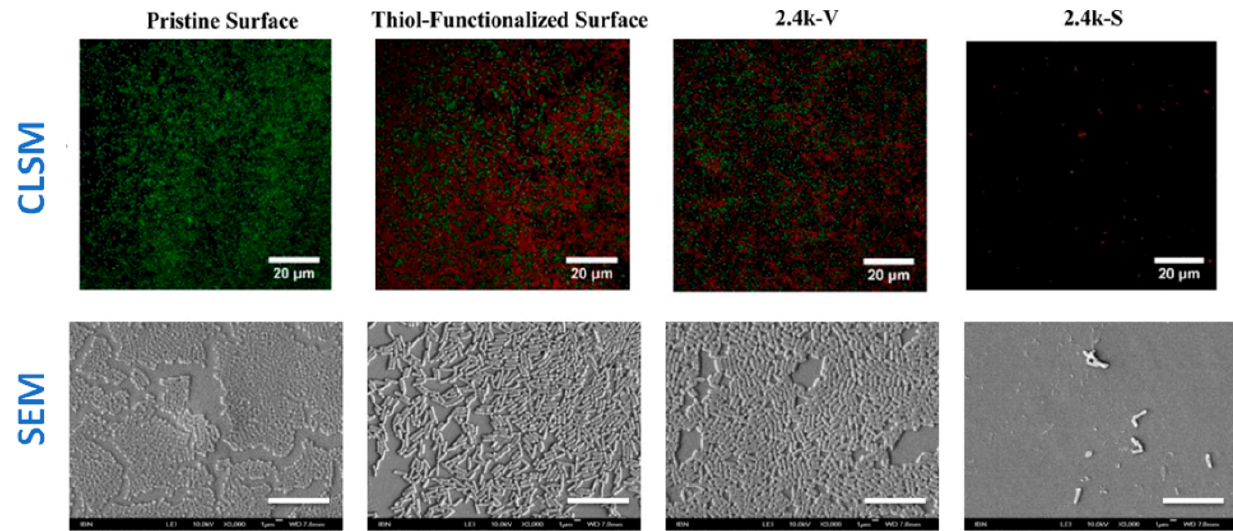
Figure 13. ( Top row ) CLSM micrographs. Images show the results of the Live/dead assay on the uncoated silicone PDMS surface and surfaces coated with thiol, 2.4k V, and 2.4 k-S for E. Coli culture after 1 day. The surfaces were imaged under confocal laser scanning microscopy (green denotes live cells; red denotes dead cells; Scale bar = 20 µ m). ( Bottom row ) FE-SEM images of E. coli after 1 day of incubation on uncoated and coated PDMS surfaces. Size of the scale bar: 10 µ m. (Reproduced with permission from Reference